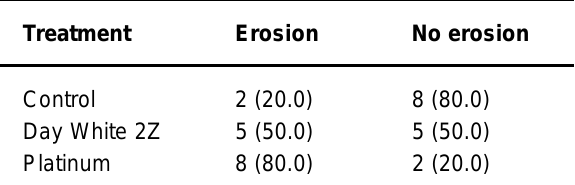
Values are expressed as